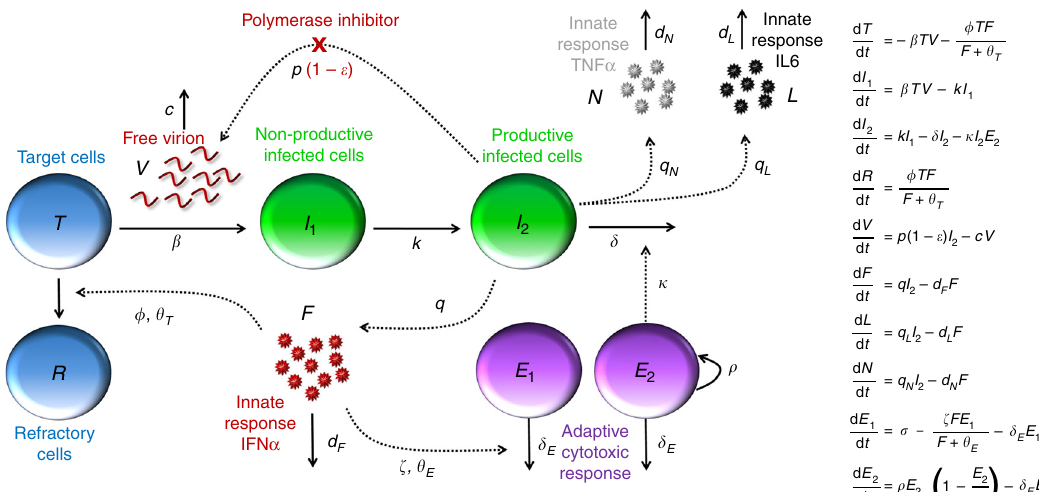
Fig. 3 Schematic and mathematical model of Ebola virus infection. As the virus early disseminate in blood and lymph circulation, the model assumes only one target cell compartment. After infection by free virus ( V ), target cells ( T ) enter an eclipse phase ( I 1 ) before becoming productively infected ( I 2 ), which activate macrophage and production of cytokines. Cytokine release, in particular IFN α , leads to an increase of cells that are refractory to infection ( R ), and triggers apoptosis of non-speci fi c CD8 T cells ( E 1 ), which creates room for proliferation of EBOV-speci fi c CD8 T cells ( E 2 ) that eliminate productively infected cells I 2 Polymerase inhibitors as favipiravir inhibit viral production with ef fi cacy